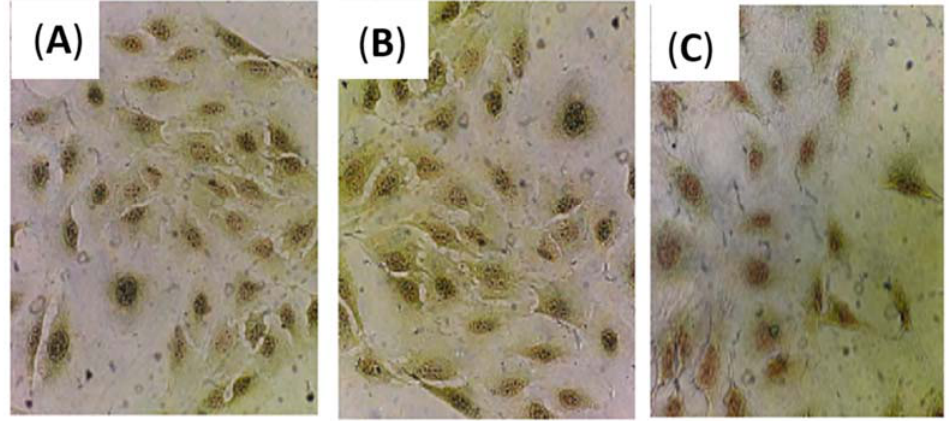
Figure 7. Morphology of NIH/3T3 cells after treated with curcumin ( a ), gold ( b ), and curcumin-gold nanoparticle ( c ).